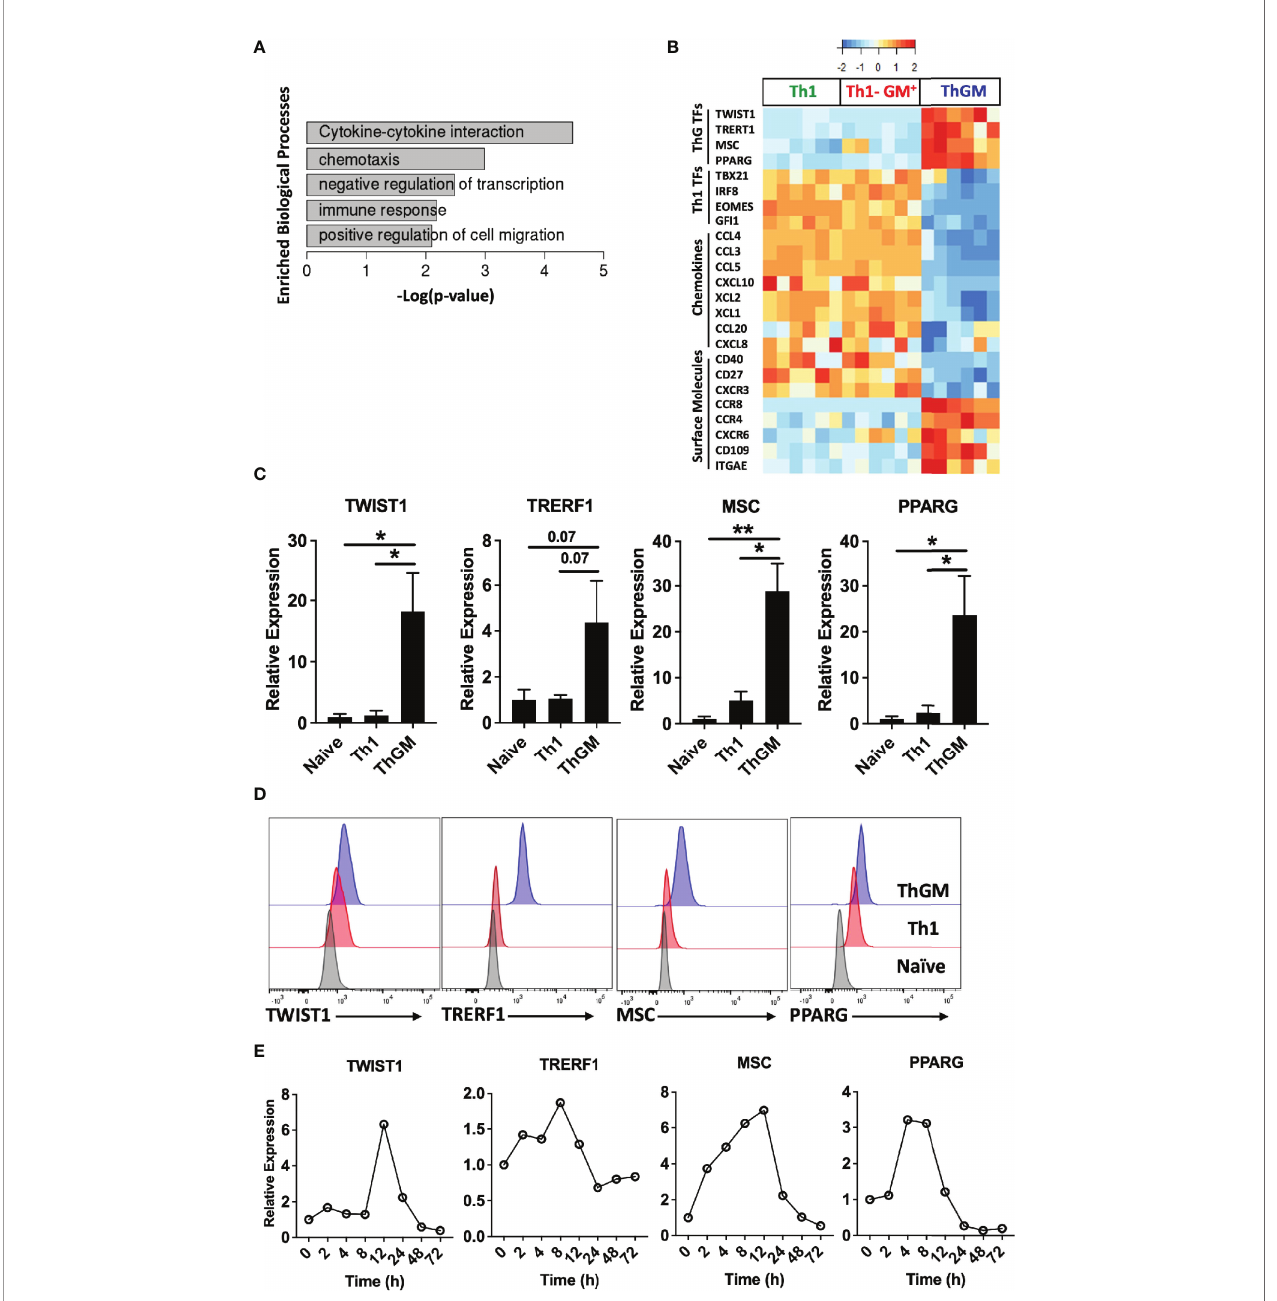
FIGURE 5 | ThGM cells express a unique set of transcription factors. Human ThGM, Th1, and GM-CSF + Th1 (Th1-GM + ) cells were isolated from total T M cells of PB of healthy donors (n = 6 subjects) using a combination of FACS sorting and cytokine capture assay. RNA was extracted and analyzed using RNA-seq analysis. (A) Bar-graph showing enriched pathways for ThGM-speci fi c genes. (B) Heatmap showing expression levels of ThGM- and Th1-speci fi c TFs, chemokines, and surface molecules. (C) RNA expression of TWIST1, TRERF1, MSC, and PPARG by FACS-sorted naïve CD4 + , Th1, and ThGM cells were determined by RT-PCR (n = 4 subjects). (D) Representative fl ow cytometry histograms for TWIST1, TRERF1, MSC, and PPARG expression by FACS- sorted naïve CD4 + , Th1, and ThGM cells. (E) Human naïve CD4 + T cells were differentiated into ThGM cells and RNA was extracted at several time points. mRNA levels for TWIST1, TRERF1, MSC, and PPARG were quanti fi ed by RT-PCR. Data shown are mean ± SEM. P-values were calculated using unpaired Student ’ s t-test with Bonferroni ’ s correction; *p < 0.05, **p <